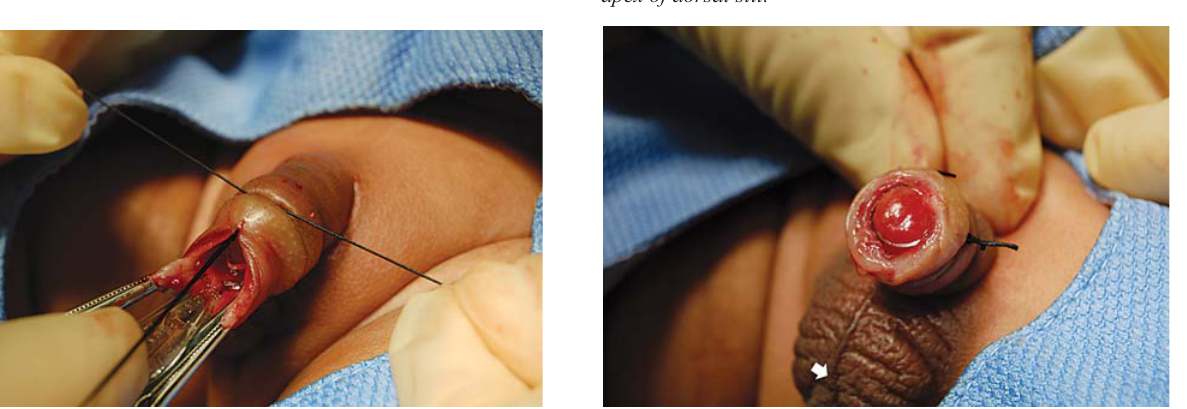
Figure 4 – Following application of a double suture, the foreskin is divided 2 mm distal to the